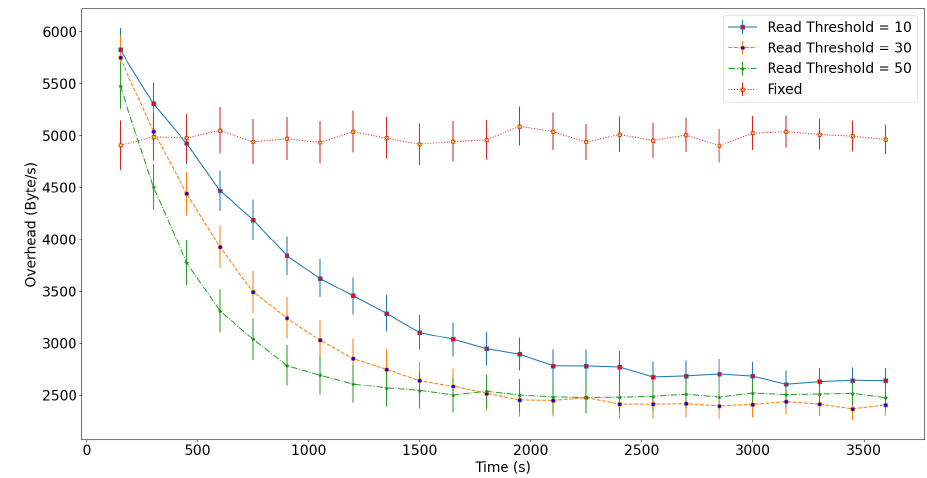
Figure 11. Overhead with different values of ThR